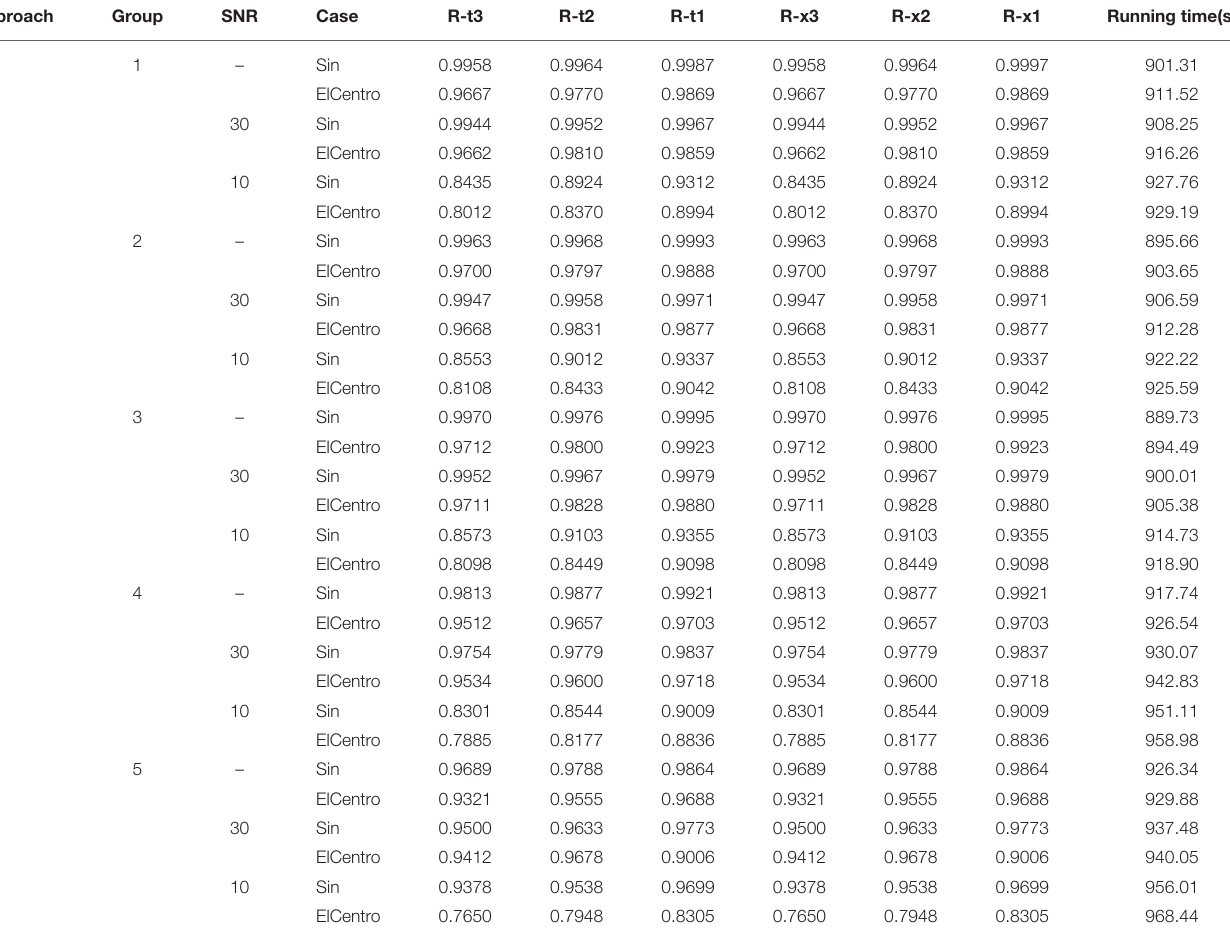
TABLE 6 | Correlation coefficient analysis (GA).